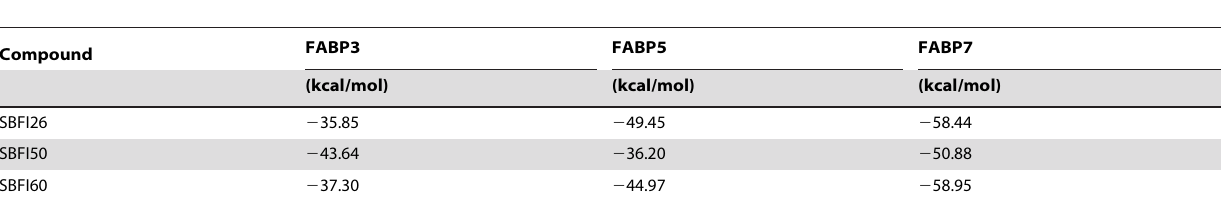
Table 1. Single-point energy calculations of inhibitors docked to FABPs.